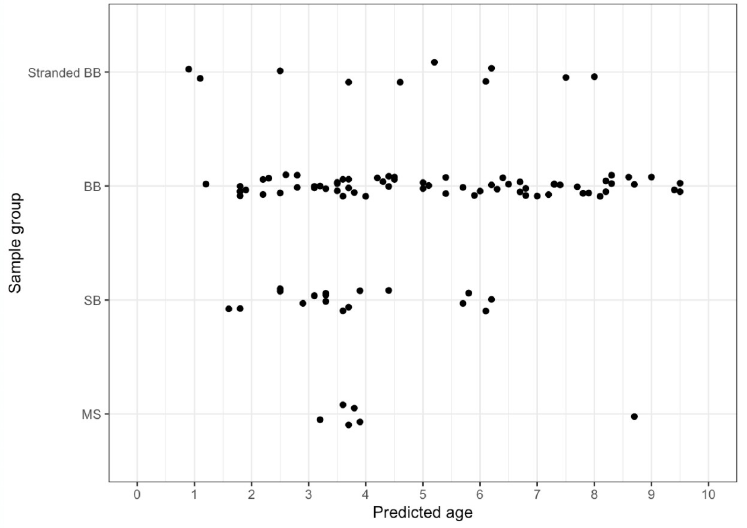
Fig 6. Predicted ages of wild dolphins using periapical dental radiography. Using the linear-log model, the pulp: tooth area ratio was used to predict ages for 91 living dolphins (from health assessments in SB, BB, and MS) and 10 dead, stranded dolphins (from BB). Age distributions should not be interpreted as representative for the populations in question, as the study design for each health assessment, sample availability and model criterion (pulp:tooth area ratio � 0.1) biased the data